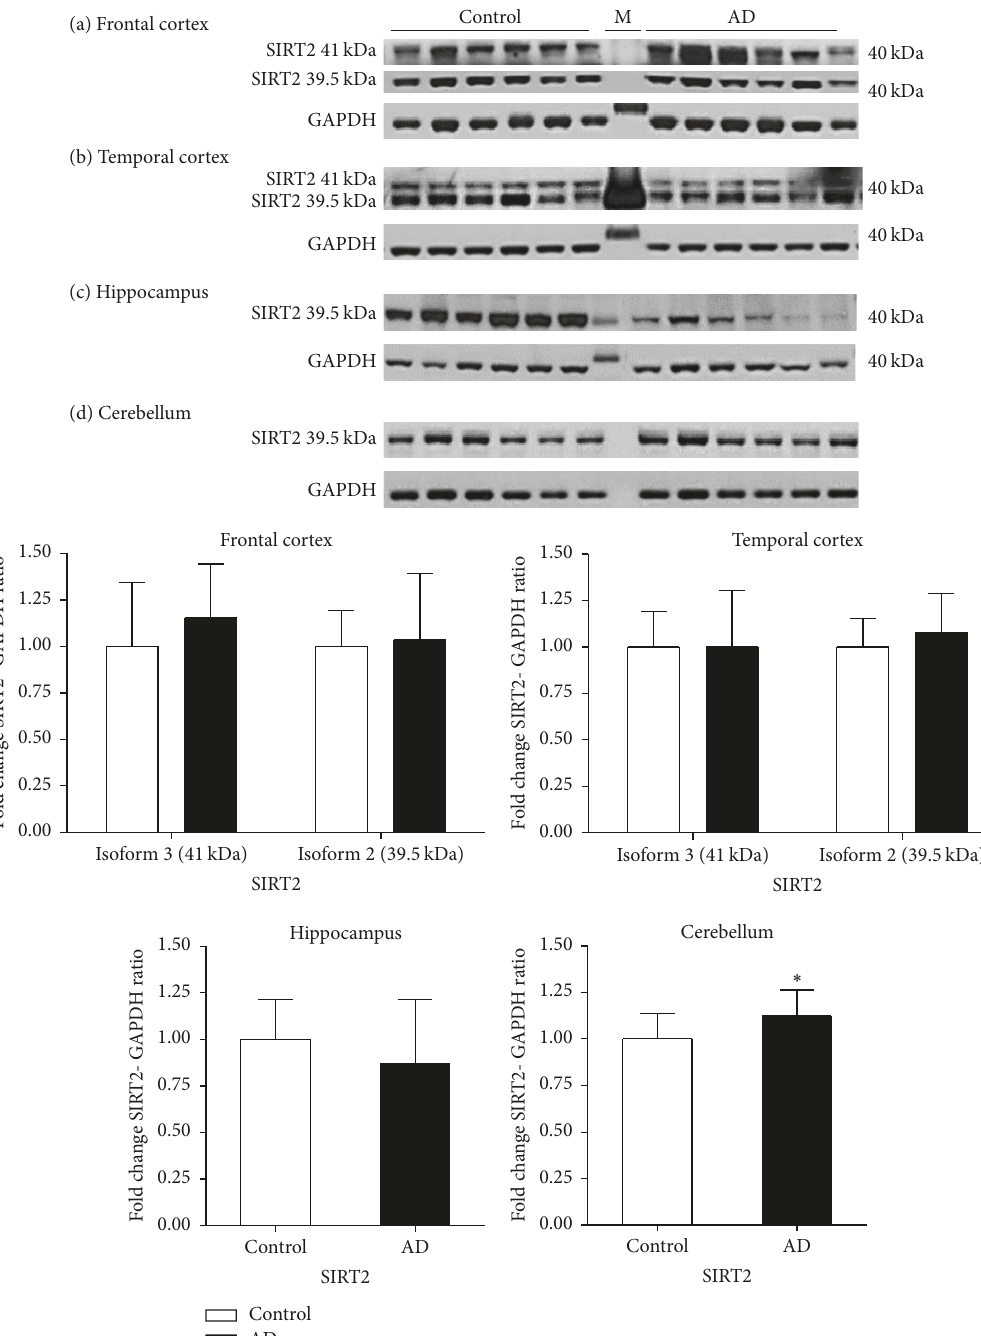
Figure 9: Expression of SIRT2 in different brain regions in Alzheimer’s disease. The levels of SIRT2 were determined in different regions of AD patients and were compared to a control-cohort. SIRT2 band intensity was normalised with GAPDH. Data are presented as fold change ( ± SD) with respect to control from three independent replicates. ∗ 𝑝 < 0.05 when compared to control; statistical analysis was done through 𝑡 -test performed on GraphPad prism. Images are representative blots of SIRT2 and GAPDH. M indicates molecular weight marker’s lane.